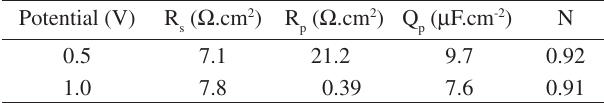
Table 3. Simulated data for Ti in iodide containing citric acid solution.